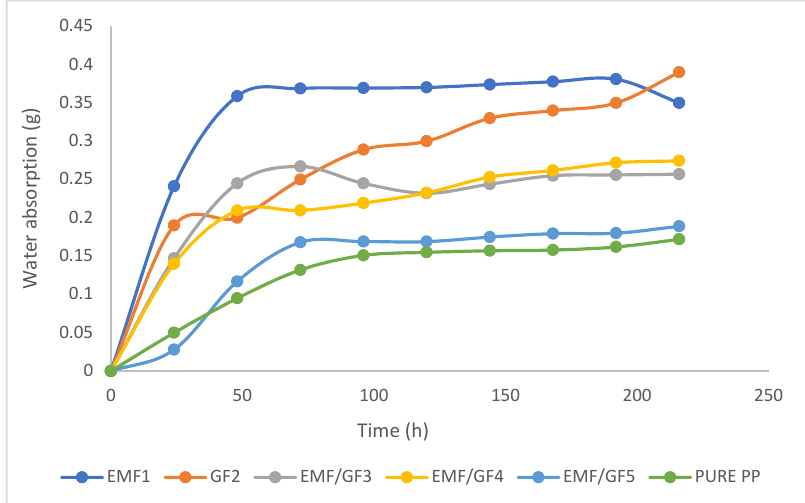
Figure 3. The moistures absorption behavior of the composites.